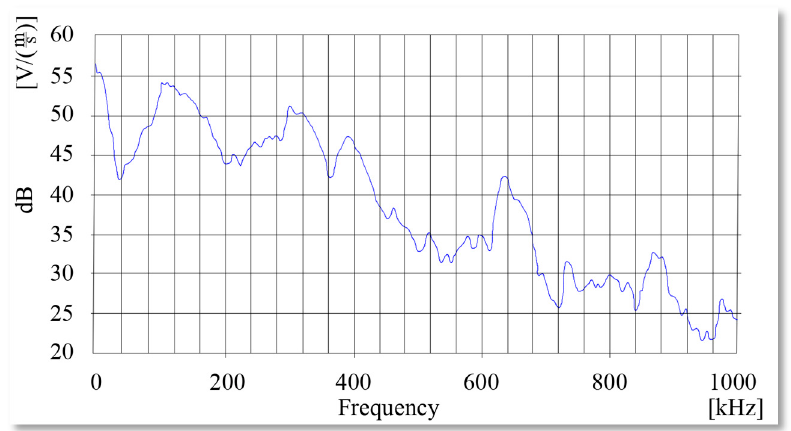
Figure 3. WS α sensor signals amplitude attenuation dependent on the